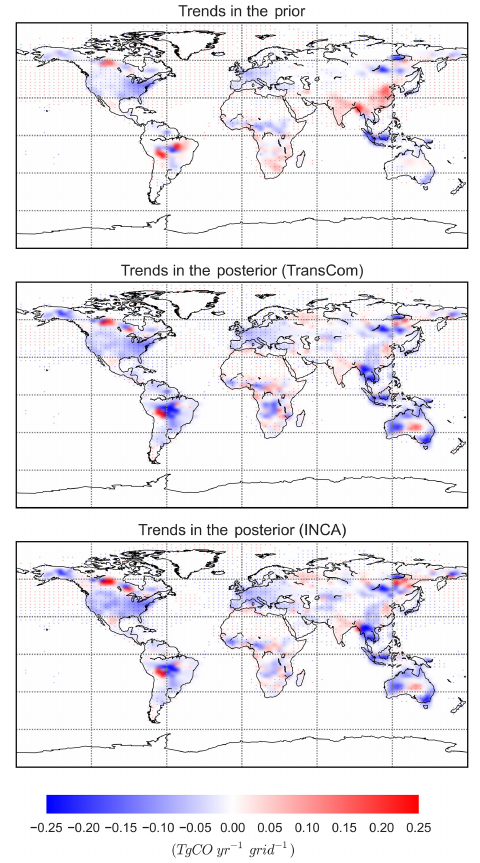
Figure 9. Trends distributions of CO surface emissions in the prior and in the posterior from 2002 to